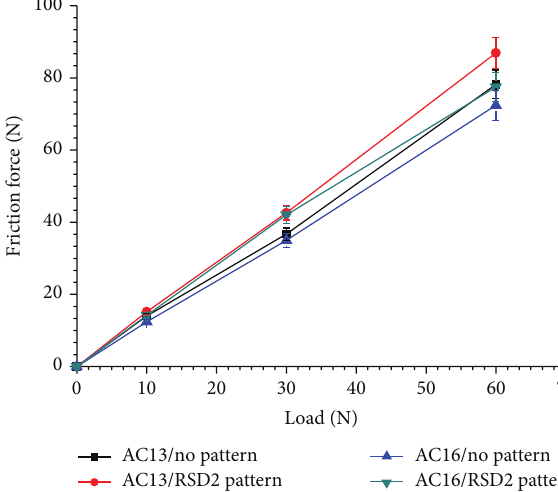
Figure 6: Friction forces versus load with AC type roads.